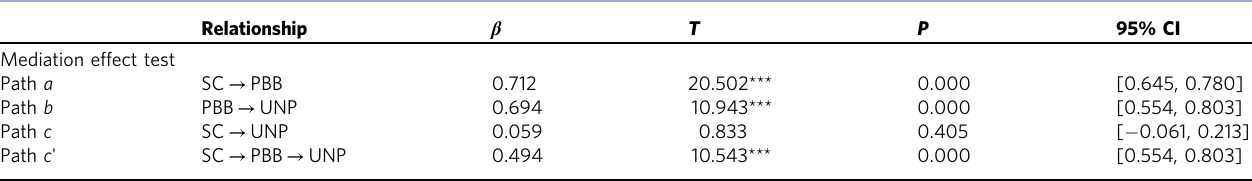
Table 5 Results of the mediation effect.